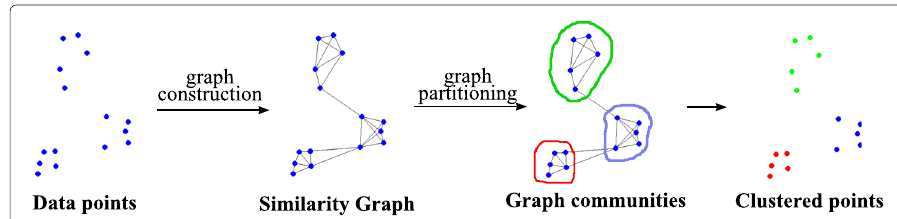
Fig. 1 Schematic diagram of the workflow for graph-based